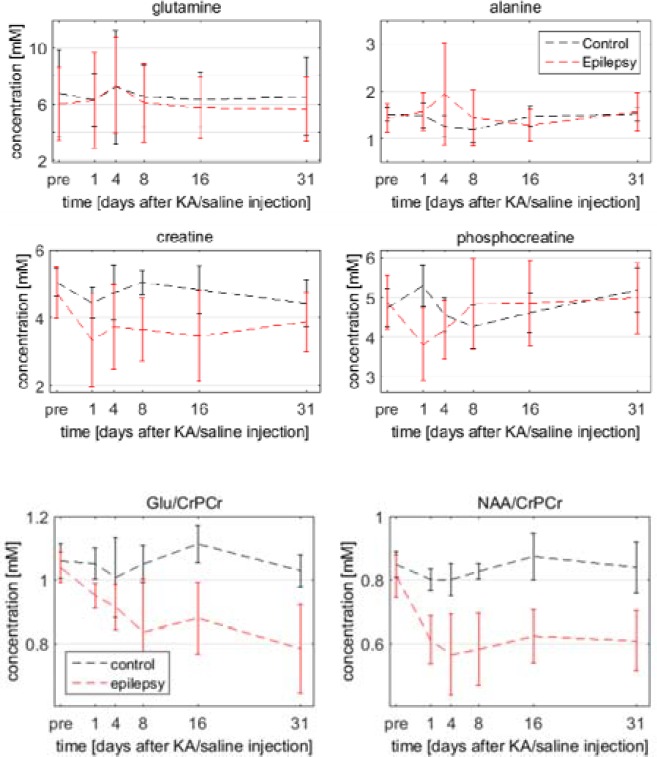
DOI:
http://dx.doi.org/10.7554/eLife.25742.025